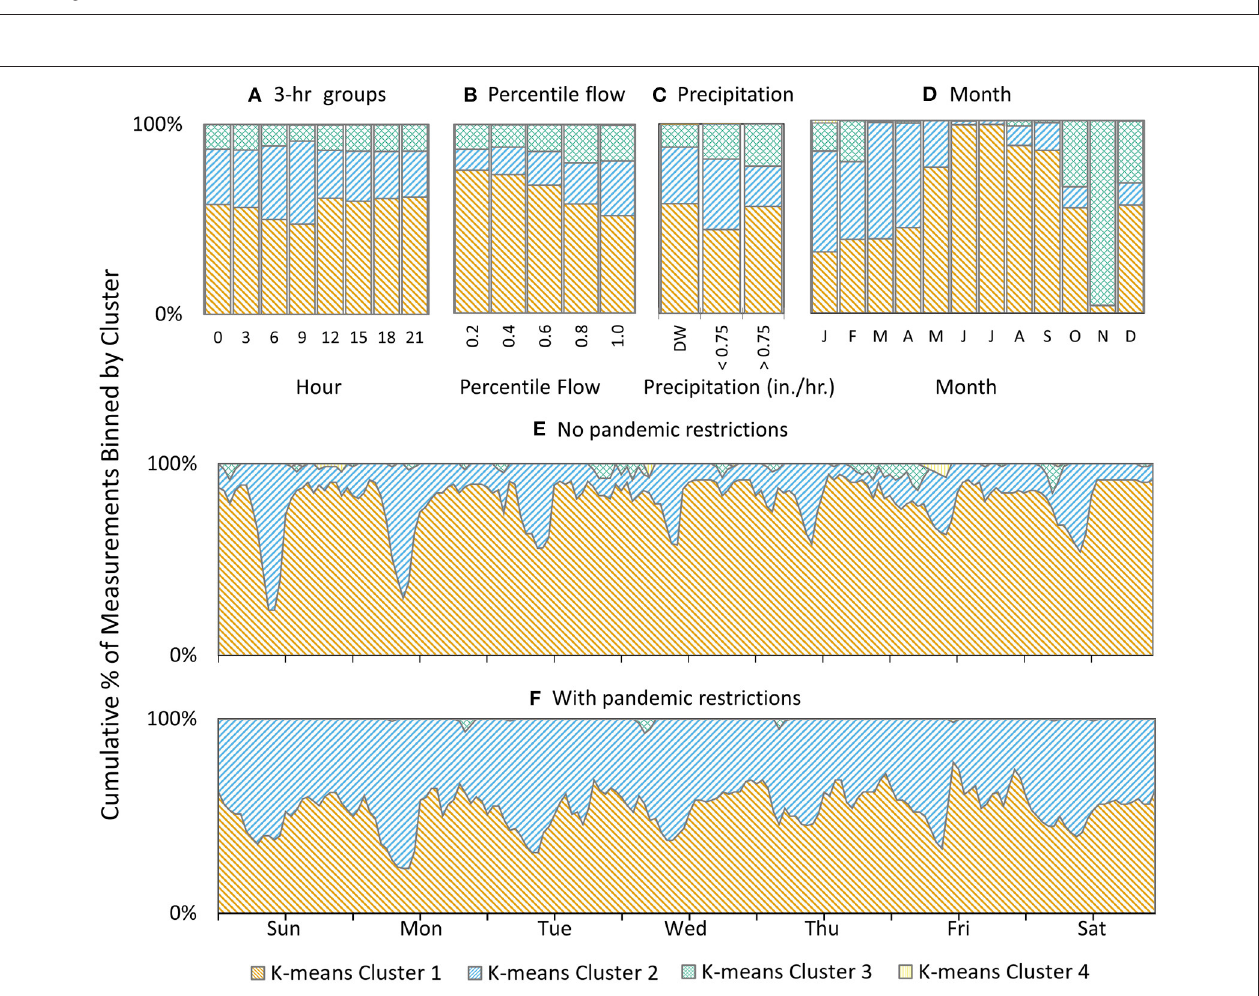
FIGURE 4 | Distribution of K-means clusters categorized by known factors, (A) time of day (3-h bins), (B) flow (20% width bins), (C) precipitation, (D) months, (E) no pandemic restrictions (March 17–June 7, 2021), and (F) with pandemic restrictions (March 17–July 6 2020.